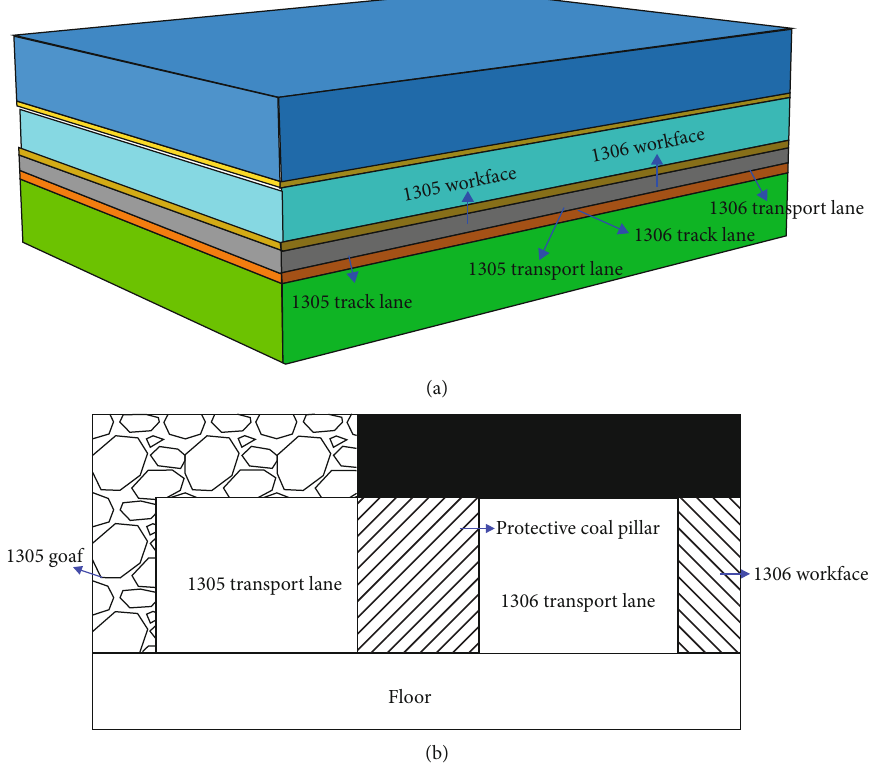
Figure 2: (a) Numerical model. (b) Schematic of the mining entries in the 1306 working